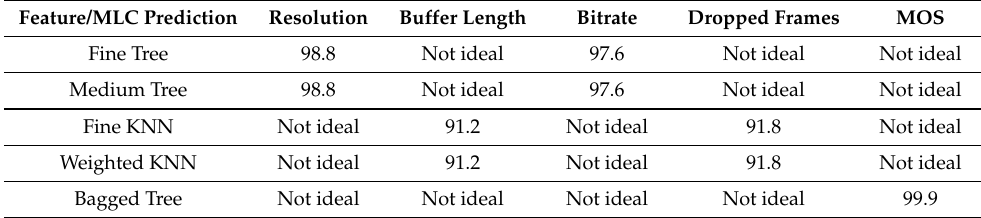
Table 9. Resulting machine learning prediction methods on noisy network training data.